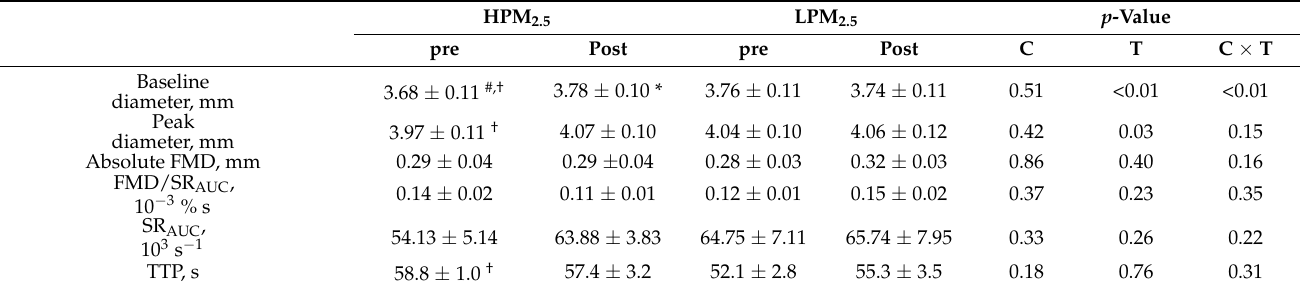
Table 3. Brachial artery diameter and flow-mediated dilation at pre- and post-exercise intervention. HPM 2.5 LPM 2.5 p -Value